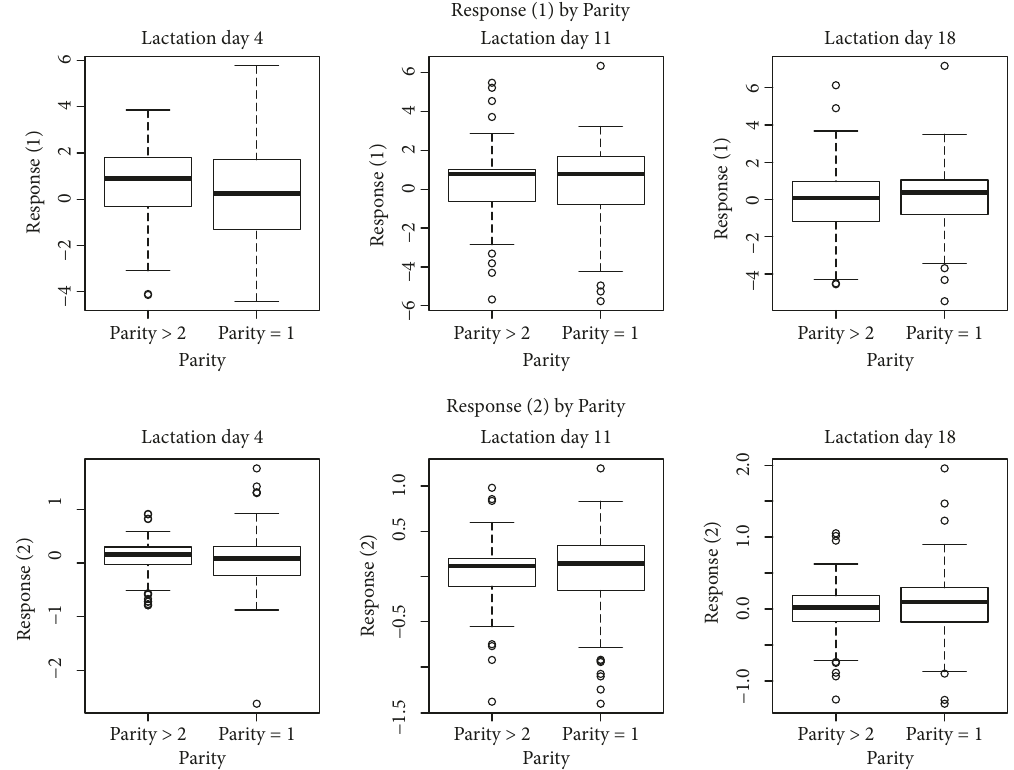
Figure 3: Top panels: back-to-back boxplots of the absolute change in feed intake at a specific day by parity. Bottom panels: back-to-back boxplots of the relative change in feed intake at a specific day by